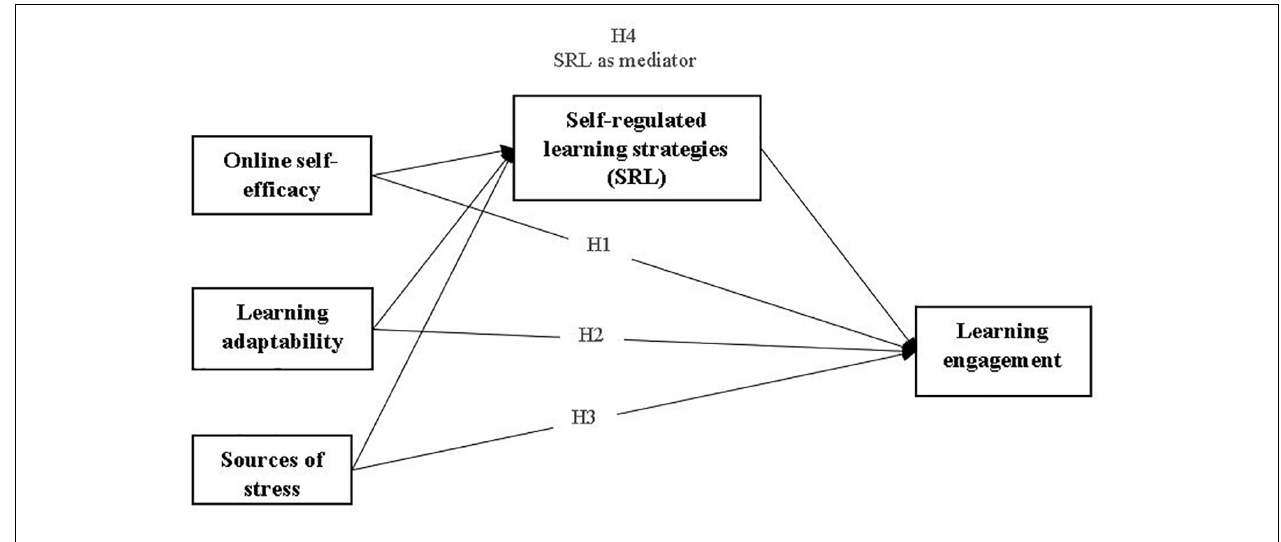
FIGURE 1 | The research